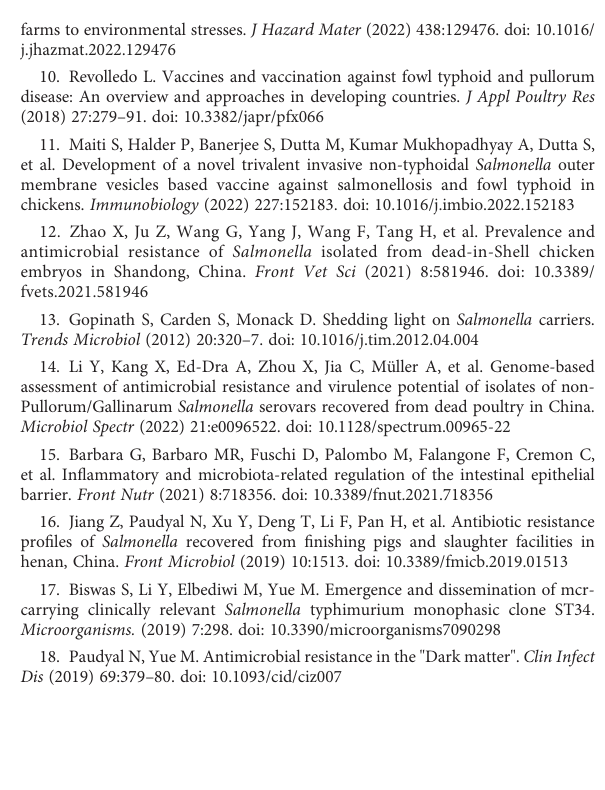
SUPPLEMENTARY FIGURE 1 Linear discriminant analysis (LDA) was used to classify chicken intestinal fl ora under different treatment conditions and evaluate the in fl uence of species with signi fi cant